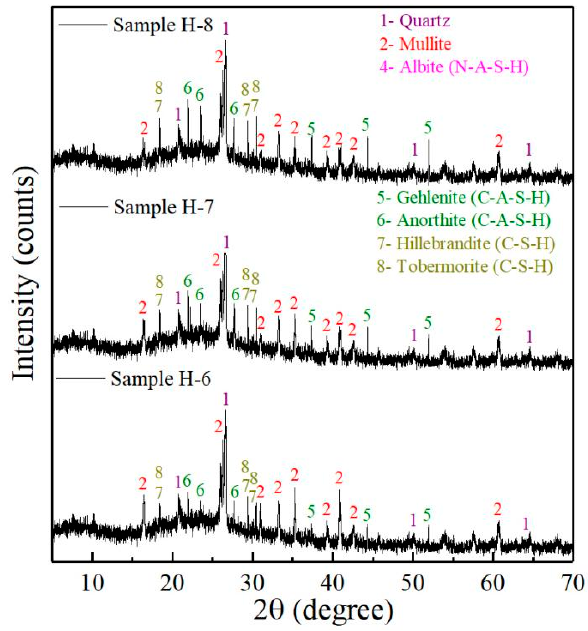
Figure 4. XRD patterns revealing the strengthening effect of GS.